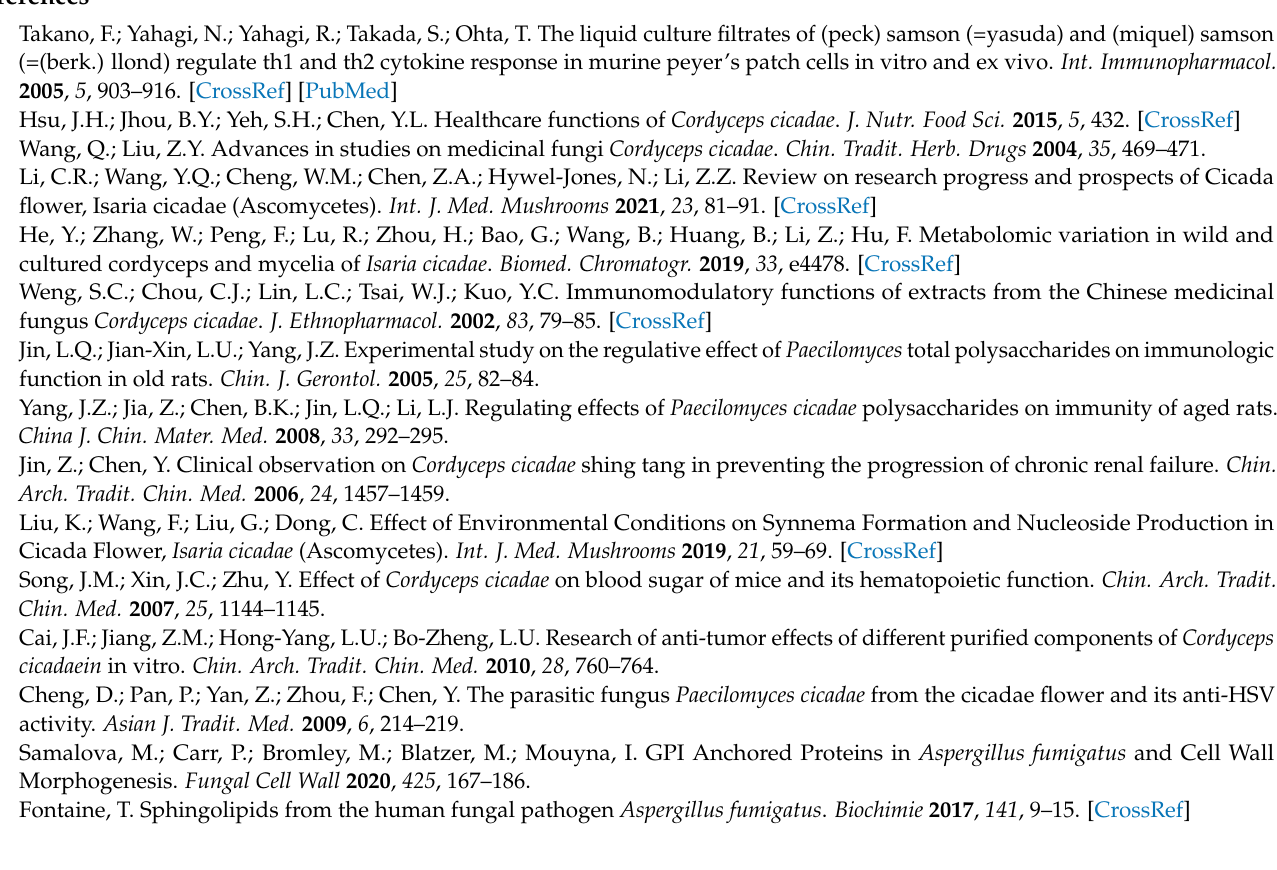
primers used in this study, Table S2: the differentially expressed genes (DEGs) between IcFBR1 mutant and Isaria cicadae wild type, Table S3: GO enrichment analysis of the differentially expressed genes (DEGs) between IcFBR1 mutant and Isaria cicadae wild type, Table S4: KEGG enrichment analysis of the differentially expressed genes (DEGs) between IcFBR1 mutant and Isaria cicadae wild type, Table S5: protein sequence and it NR functional